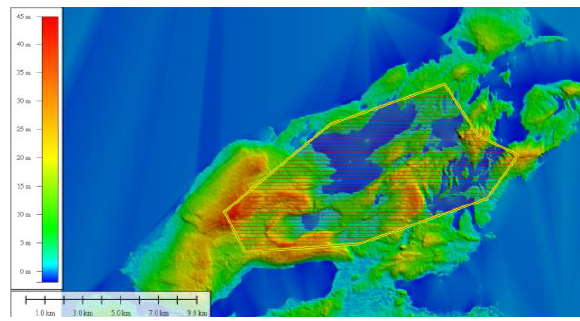
Figure 12. closed polygon for height difference test Figure 13. the longitudinal profile (1) from DTM. In the longitudinal profile (1) a DSM-DTM graph is obtained, see Figure 14. The DSM (red) and DTM (blue lines) charts in the elongated profile area (1). On the left side of the graph can be seen higher vegetation height when passing through the forest land cover. Vegetation height is 25-70 m. On the middle side of the graph the DSM value coincides with DTM. This area is Oemasapoka Lake. Then on the right side of the graph there is a high but not large difference. This region is low vegetation located in the steppe savanna. On the right side of the graph there is also Lake Oeapa and the condition of DSM coincides with DTM.